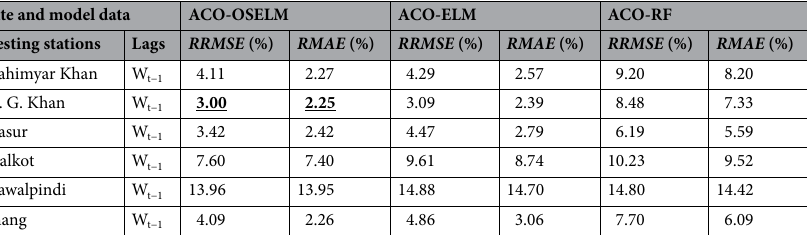
Table 8. Geographic comparison of the accuracy of the ACO-OSELM versus ACO-ELM and ACO-RF models in terms of relative root mean squared error ( RRMSE , %) and the relative mean absolute error ( RMAE , %) computed within the test stations. Note that the best model is boldfaced